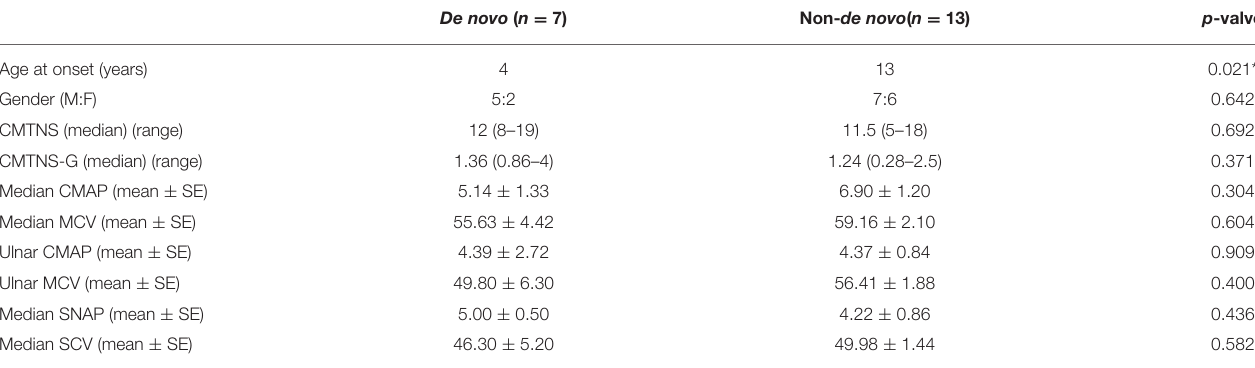
TABLE 4 | The comparison between de novo group and non- de novo